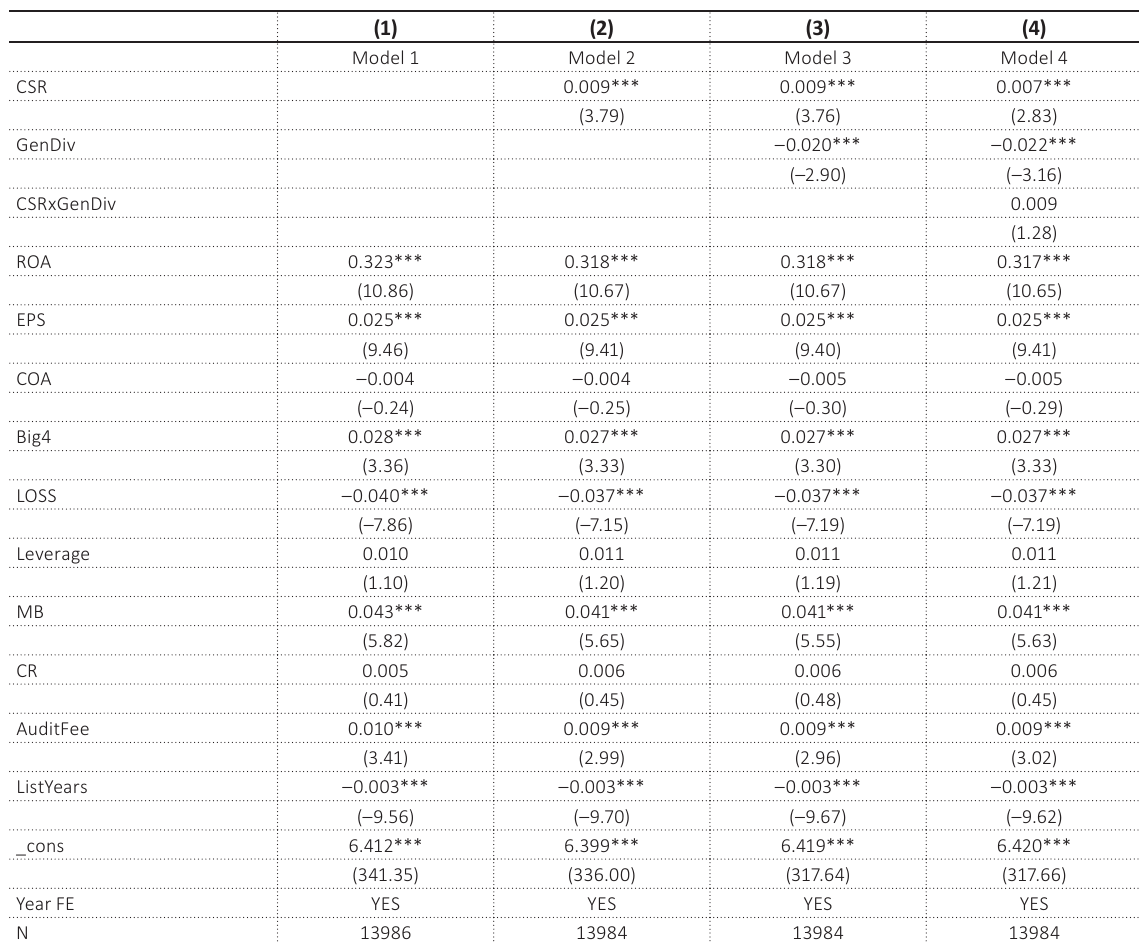
Table 7. Regression results